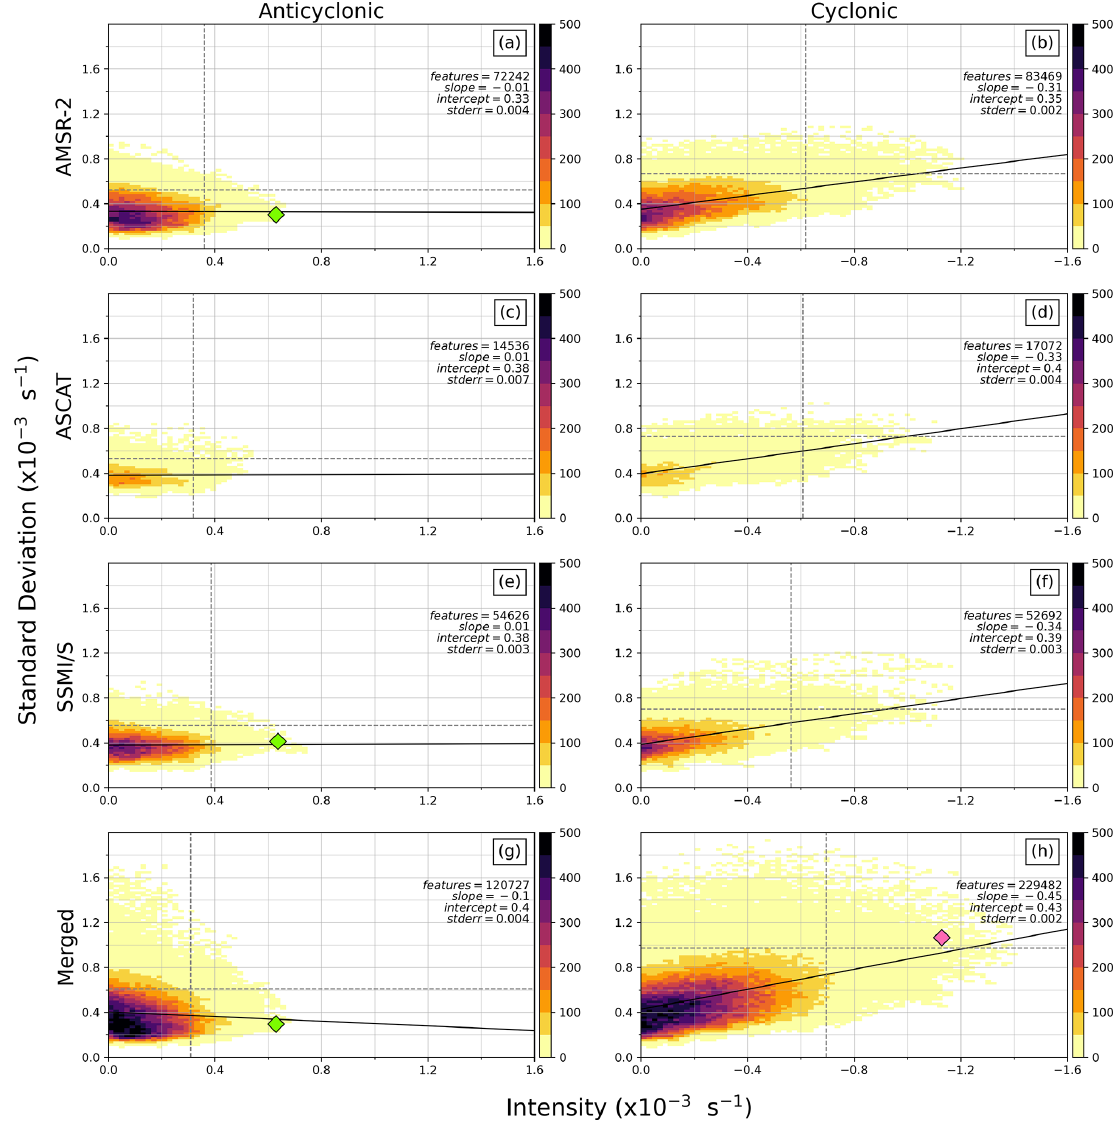
Figure 4. A two-dimensional histogram of the intensity and standard deviation of vorticity of all features detected between 2017–2020. Anticyclonic and cyclonic features are shown in the left and right columns respectively, while each product is shown in a different row. Panels (a) and (b) show features detected using the AMSR-2 product, panels (c) and (d) using the ASCAT product, panels (e) and (f) using the SSMI/S product family, and panels (g) and (h) using the merged product. The lines of best fit are shown with a black solid line, along with its slope, intercept, standard error, and the number of features detected. The vertical and horizontal dashed lines represent the 95th percentiles of the intensity and standard deviation respectively. The colour map indicates the number of features detected in each bin. The anticyclonic feature described in Case study 2 is shown with a green diamond marker, and the cyclonic feature described in Case study 1 is shown with a magenta diamond marker (Sect. 4.1). Note the relative scaling order of magnitude between variables and the reverted x axis for cyclonic features to aid comparison. The gradients of the lines of best fit reported in the Results (Sect. 4.2) have been computed using the absolute values of the x axis to simplify the comparison between the cyclonic and anticyclonic